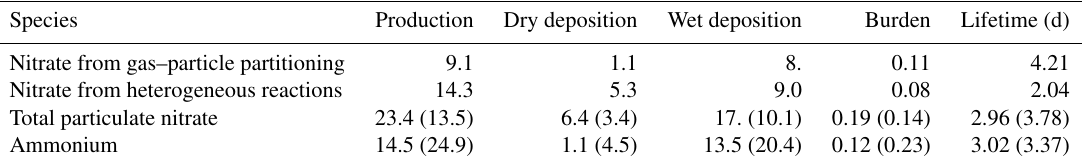
Table 3. The 2017 global budget of nitrate aerosol from gas–particle partitioning and heterogeneous reactions and of ammonium aerosol as simulated by IFS-AER CY47R1 (fluxes are expressed in TgNyr − 1 ; burden is expressed in TgN). The median values from Bian et al. (2017) are indicated in parentheses when they are available and comparable.